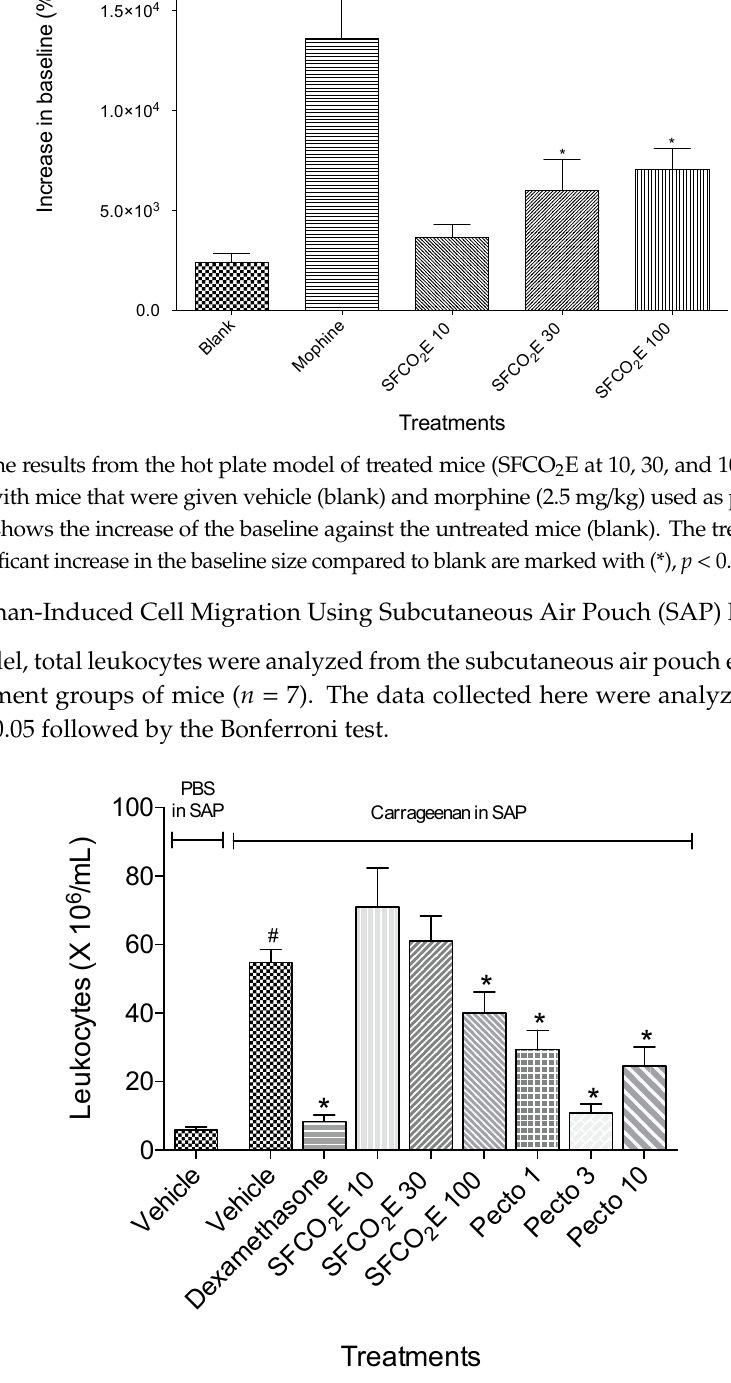
Figure 7. The results from the total leukocytes migration to the air pouch of treated mice (SFCO 2 E at 10, 30, and 100 mg / kg, pectolinarigenin at 1, 3, and 10 mg / kg or dexamethasone at 2.5 mg / kg were compared with mice that were given vehicle by oral gavage 60 min before carrageenan (1%, 1 mL) or PBS (1 mL) injection into subcutaneous sir pouch (SAP). This figure shows the decrease of the bar against the carrageenan injected group that received vehicle (p.o). The treatments that show a significant decrease in the bar size compared to the group receiving carrageenan are marked with (*), p < 0.05. (#), p < 0.01.